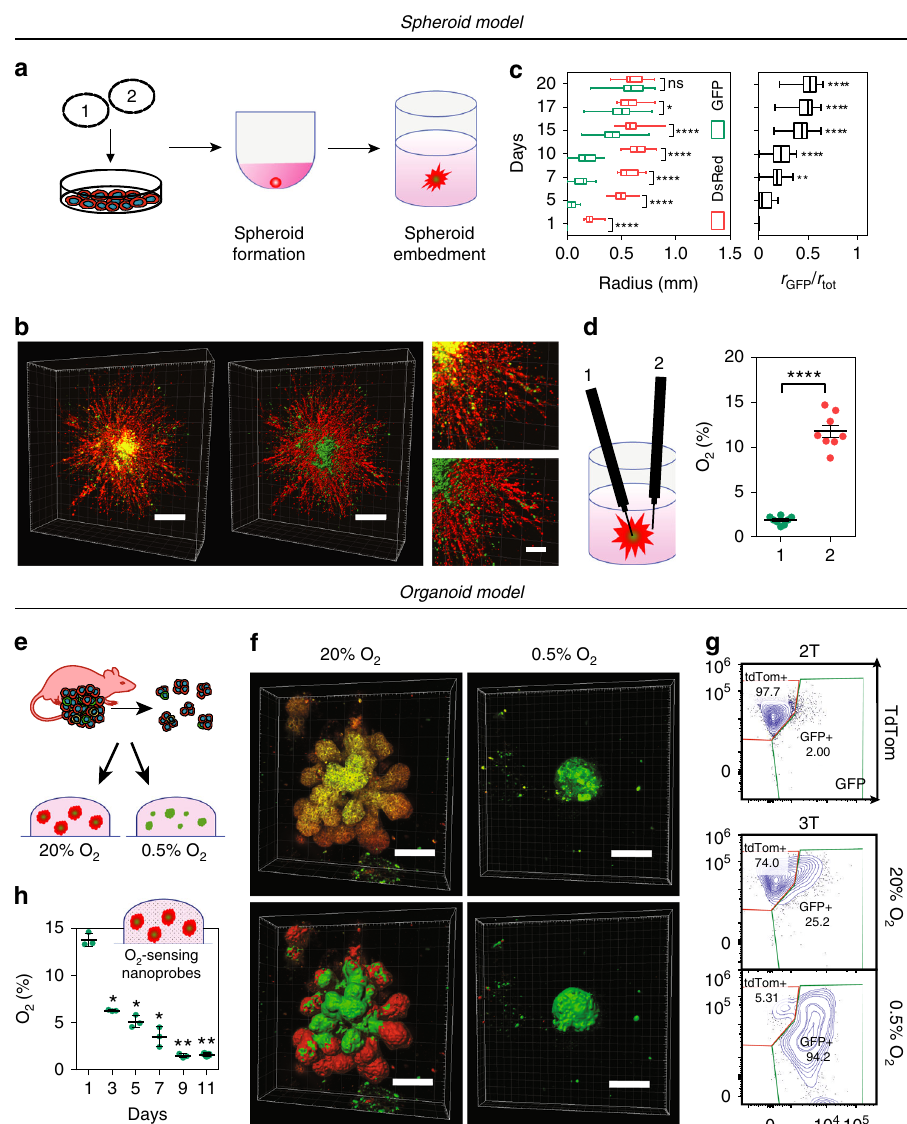
Fig. 3 Fate mapping of hypoxic cells in 3D models. a Hypoxia fate-mapping cells were used to generate 3D spheroid cultures. Spheroids were formed in spheroid formation media in round-bottom well plates and transferred to the center of 3D collagen matrices 72 h later. b 3D reconstruction of a spheroid imaged after 15 days in culture and correspondent 3D surface rendering (right and bottom). Scale bar: 500 μ m (left), 200 μ m (right). c Analysis of color distribution measured along the spheroid radius (mean ± SEM, N = 3, n = 27); **** P < 0.0001 GFP versus DsRed on each day (Two-way ANOVA with Bonferroni posttest) (left). Length of the GFP + radius (r GFP ) over the total spheroid radius (r tot ) (mean ± SEM, N = 3, n = 27); **** P < 0.0001 versus day 5 (one-way ANOVA with Bonferroni posttest) (right). The box extends from the 25th to 75th percentiles, the median is marked by the vertical line inside the box, and the whiskers represent the minimum and maximum points. d O 2 measurements in the core (1) or periphery (2) of MDA-MB-231 spheroids following 20 days in culture under 20% O 2 (mean ± SEM, N = 8); **** P < 0.0001 position 1 versus 2 (two-tailed t -test). e Organoids derived from 3 T mouse tumors were embedded in 3D in Matrigel and cultured under 20% or 0.5% O 2 . f 3D reconstruction of fl uorescent images of organoids following 10 days of culture under 20% or 0.5% O 2 with corresponding 3D surface rendering (bottom). Scale bar: 100 μ m. g Representative contour plots of fl ow cytometry data from 3 T mouse tumor organoids cultured under 20% or 0.5% O 2 for 20 days. 2 T tumor organoids were used to de fi ne tdTom + and GFP + gates for fl ow cytometry analysis (Supplementary Fig. 4d). h O 2 measurements performed by using OXNANO nanoprobes dispersed in 3D Matrigel surrounding embedded organoids (mean ± SEM, N = 3, n > 200); **** P < 0.0001 versus day 1 (matched one-way ANOVA with Bonferroni